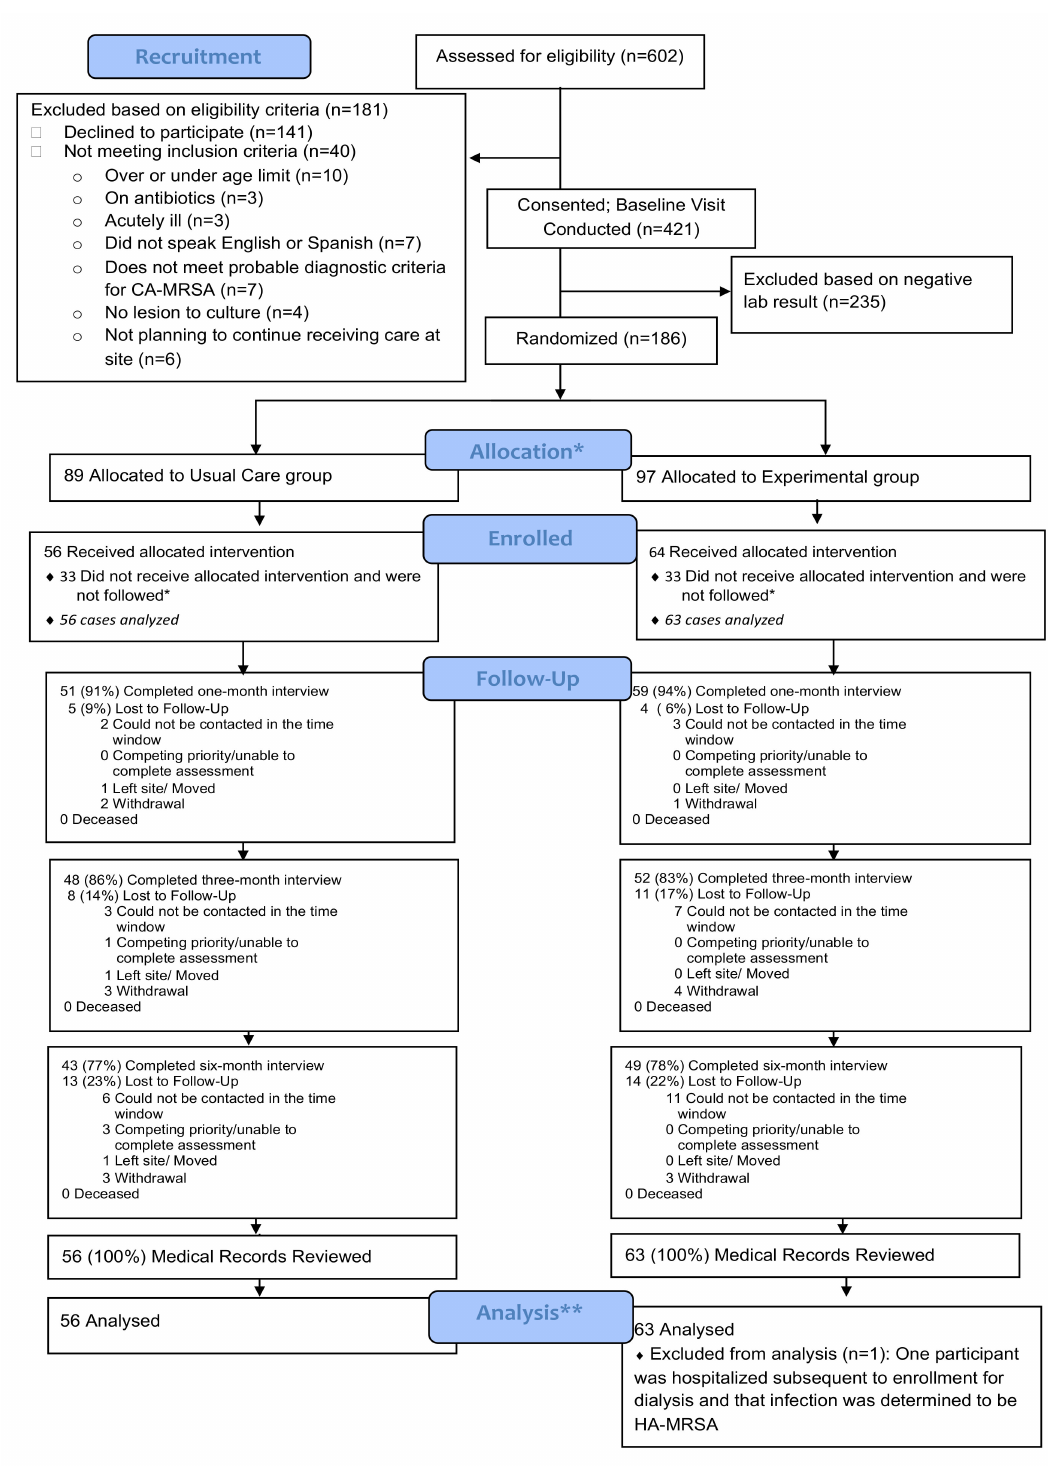
Figure 1. CONSORT Diagram. * “Intent-to-treat” (ITT) cohort (n = 186) ** “Analysis” cohort (n = 119). An additional n = 66 participants were eligible for participation based on having either MRSA+/MSSA+ wound culture and provided informed consent; however, these participants did not complete the baseline home visit, and therefore never received the intervention. Since these participants had consented to be followed, their six-month chart review data were extracted and are provided as an additional “observation-only control group” (n = 63 of these participants were analyzed, for a 95.5% response rate). Upon subsequent chart review, one patient was determined subsequently to have met criteria for HA-MRSA and considered ineligible and these data were removed from the analysis, leaving n = 119 (“analysis cohort”). Data collection spanned from 11/01/2015 to